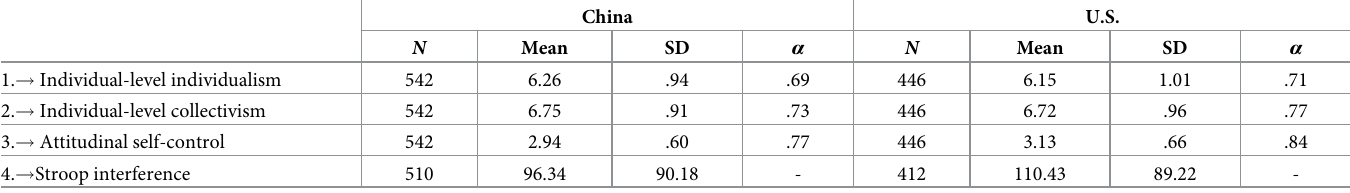
Table 1. Descriptive statistics of individual-level individualism-collectivism, and attitudinal and behavioral self-control. China